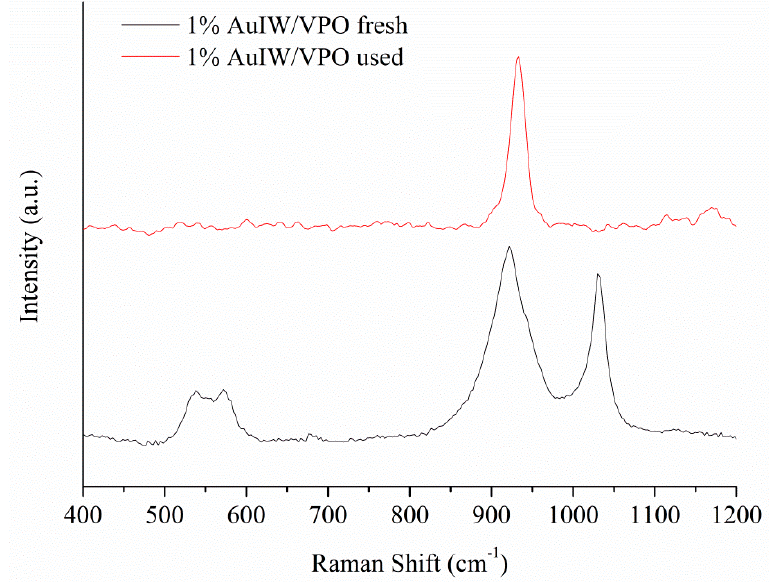
Figure 6. Raman spectra of fresh and used 1% Au IW /VPO catalysts.